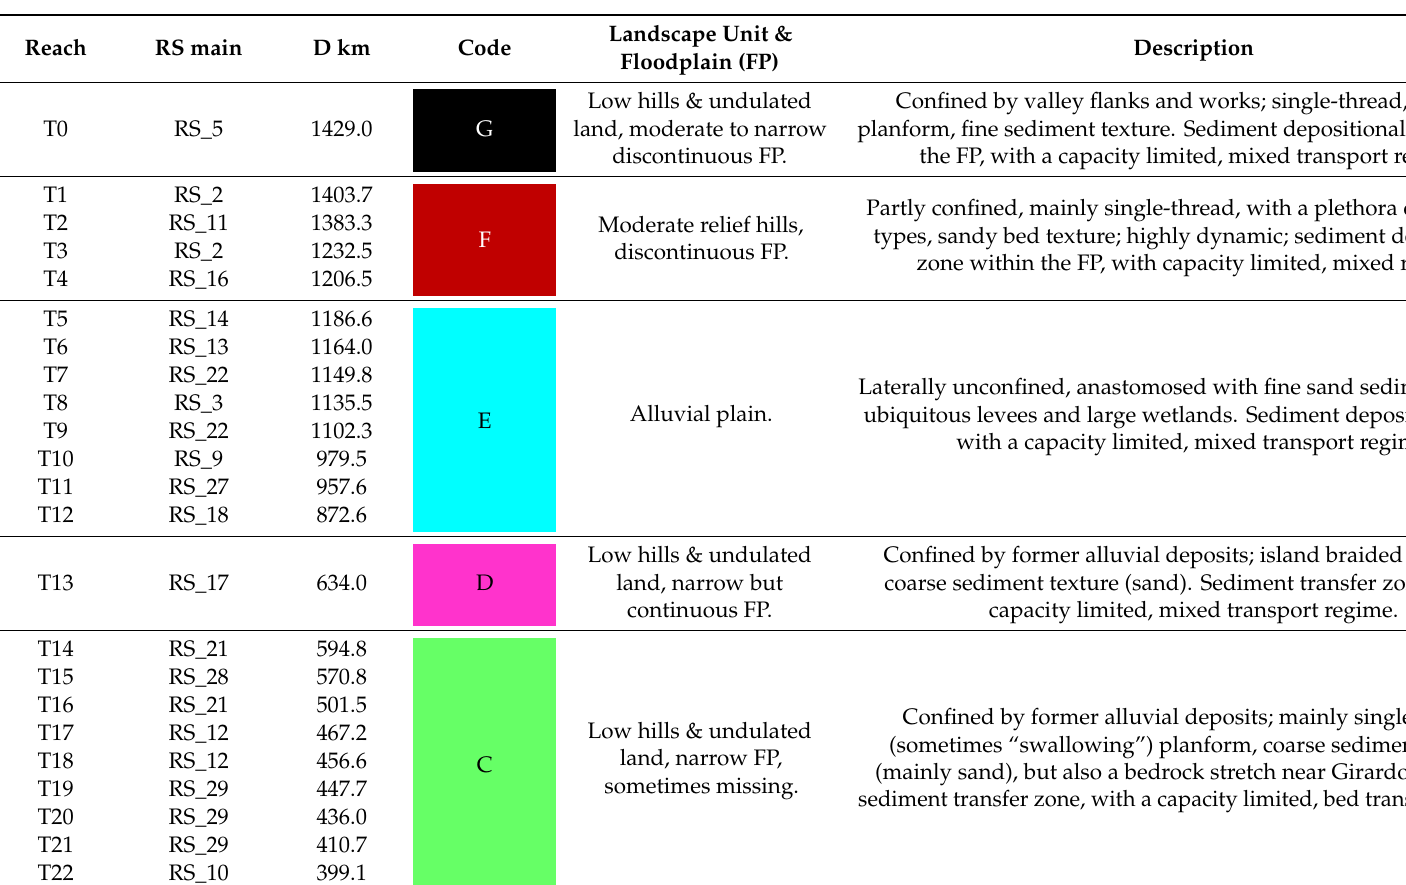
Table 3. Resumed version of encountered River Styles of the Magdalena